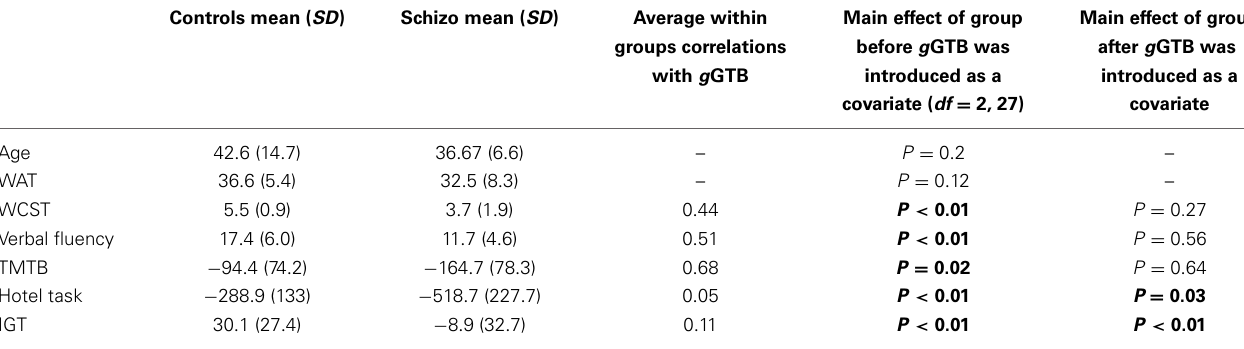
Table 1 | Patient and control scores and significance of group differences, before and after g GTB was introduced as a covariate. Controls mean ( SD